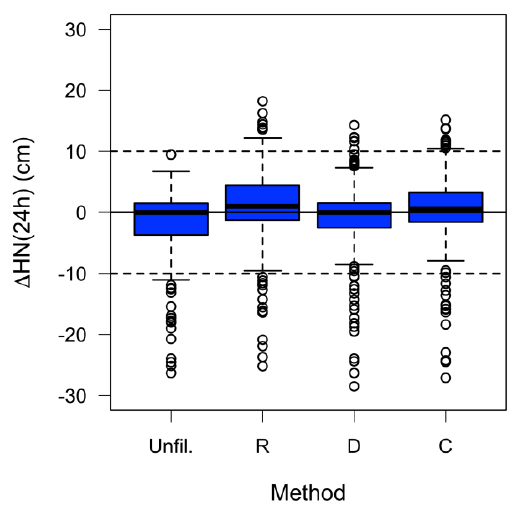
Fig. 4. Difference between simulated and observed 24h new snow amounts. Replaces Fig. 5 of the original paper. Figure 4: Difference between simulated and observed 24-hour new snow amounts. 74 Replaces Figure 5 of the original paper. 75 Table 1. Comparison of three measured and simulated 24h new snow events HN (24h). In addition, the measured (Obs.) and fore- casted (GEM) precipitation amounts are given as well as the corre- sponding snow density for the three days. Replaces Table 2 of the Table 1: Comparison of three measured and simulated 24-hour new snow events 76 original paper. HN(24h). In addition, the measured and forecasted precipitation amounts are given 77 as well as the corresponding snow density for the three days. Replaces Table 2 of 78 the original paper. 79